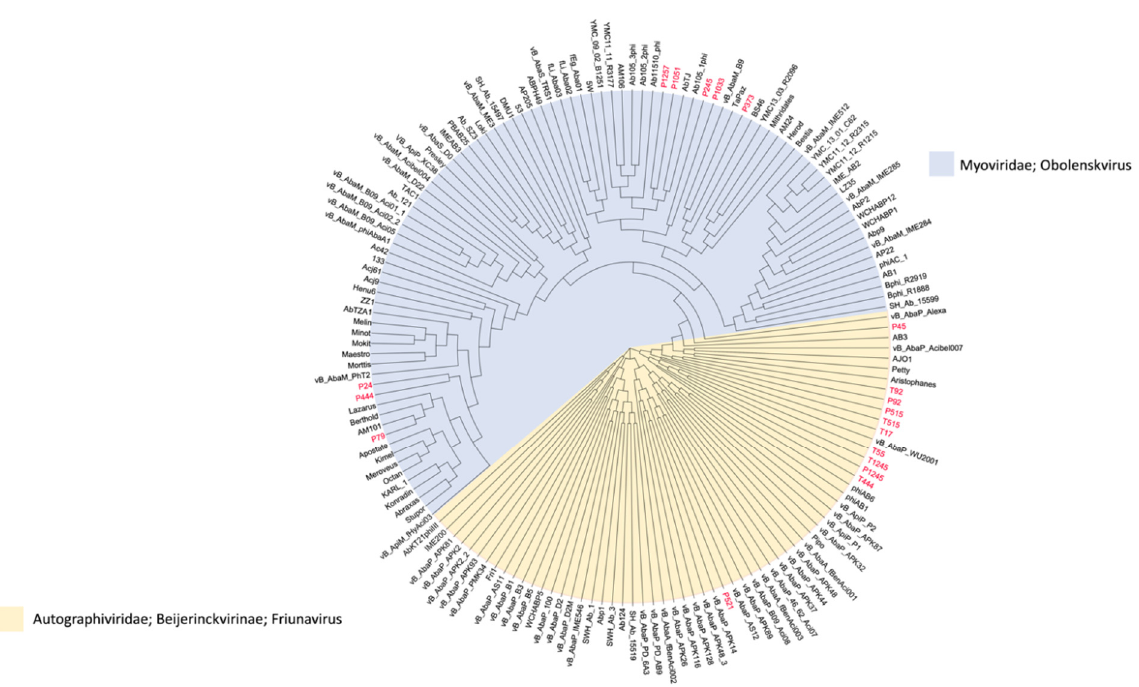
Figure 8. Whole-genome neighbor-joining phylogeny inferred from MASH distances of assemblies in the GenBank data set. The isolated phages used in this study are in red color, the family/genus of each phage is represented as a colored background, and a tab-delimited matrix of the MASH distances between each pair of isolates is presented as supplementary data.